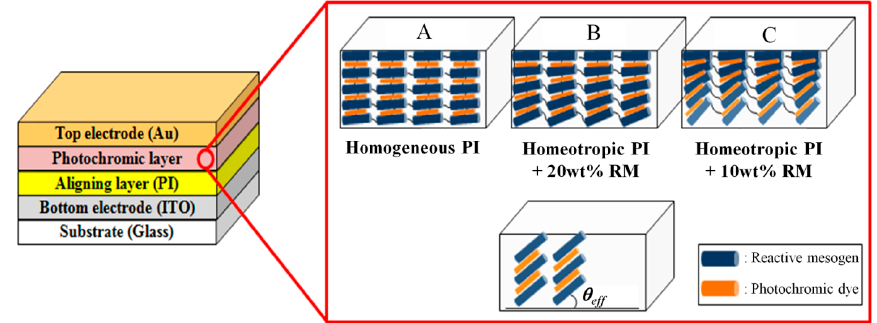
Figure 2. Schematics of the MIM structure for electrical measurement of UV intensity with the photochromic film. Tilting orientation angles of the photochromic dyes in the film are controlled by UV-cured liquid crystalline RM with the guest-host effect and polar RM anchoring conditions of the alignment layer.